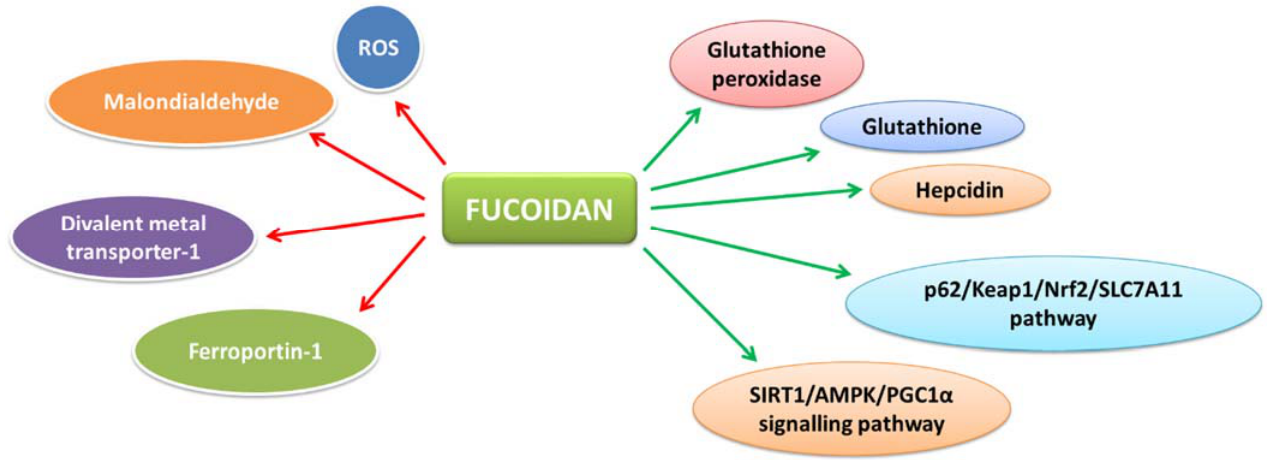
Figure 3. Hepatoprotective action of fucoidan. Fucoidan increases the levels of glutathione peroxidase ‐ 4, glutathione and hepcidin; ameliorates alcohol ‐ induced ferroptosis damage in the liver by up ‐ regulation of p62/Keap1/Nrf2/SLC7A11 pathway; activates SIRT1/AMPK/PGC1 α signaling pathway in non ‐ alcoholic liver disease. (Green arrows indicate increase in synthesis or up ‐ regulation of gene expression). Glutathione peroxidase and glutathione scavenge free radicals. Hepcidin reduces iron absorption through ubiquitin ‐ dependent proteasome degradation of divalent metal transporter ‐ 1 (DMT1); p62 recruits ubiquitinated Keap1 proteins to autophagosomes and promotes expression of Nrf2; Nrf2 promotes downstream gene transcription of SLC7A11; SLC7A11 is a transmembrane protein responsible for the cystine/glutamate antiporter to import cystine for glutathione biosynthesis and antioxidant defense. Fucoidan activates SIRT1/AMPK/PGC1 α signaling pathway which reduces lipotoxicity ‐ related oxidative stress and inflammation. Fucoidan reduces ROS in hepatocytes; reduces the levels of malondialdehyde, divalent metal transporter ‐ 1 and ferroportin ‐ 1 to prevent iron overload. (Red arrows indicate decrease in synthesis or activity).